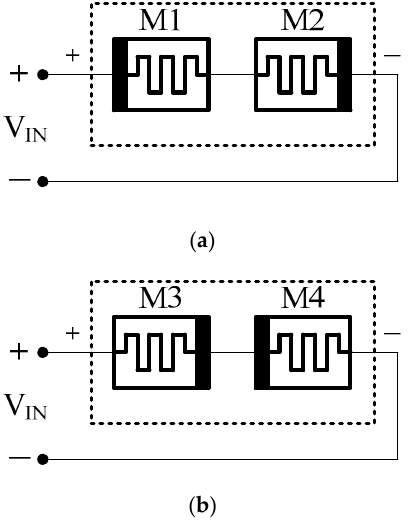
Figure 6. Memristor circuit with two memristors connected anti-serially. ( a ) M1 and M2 connected back to back in series; ( b ) serial connection with opposite polarities using M3 and M4.